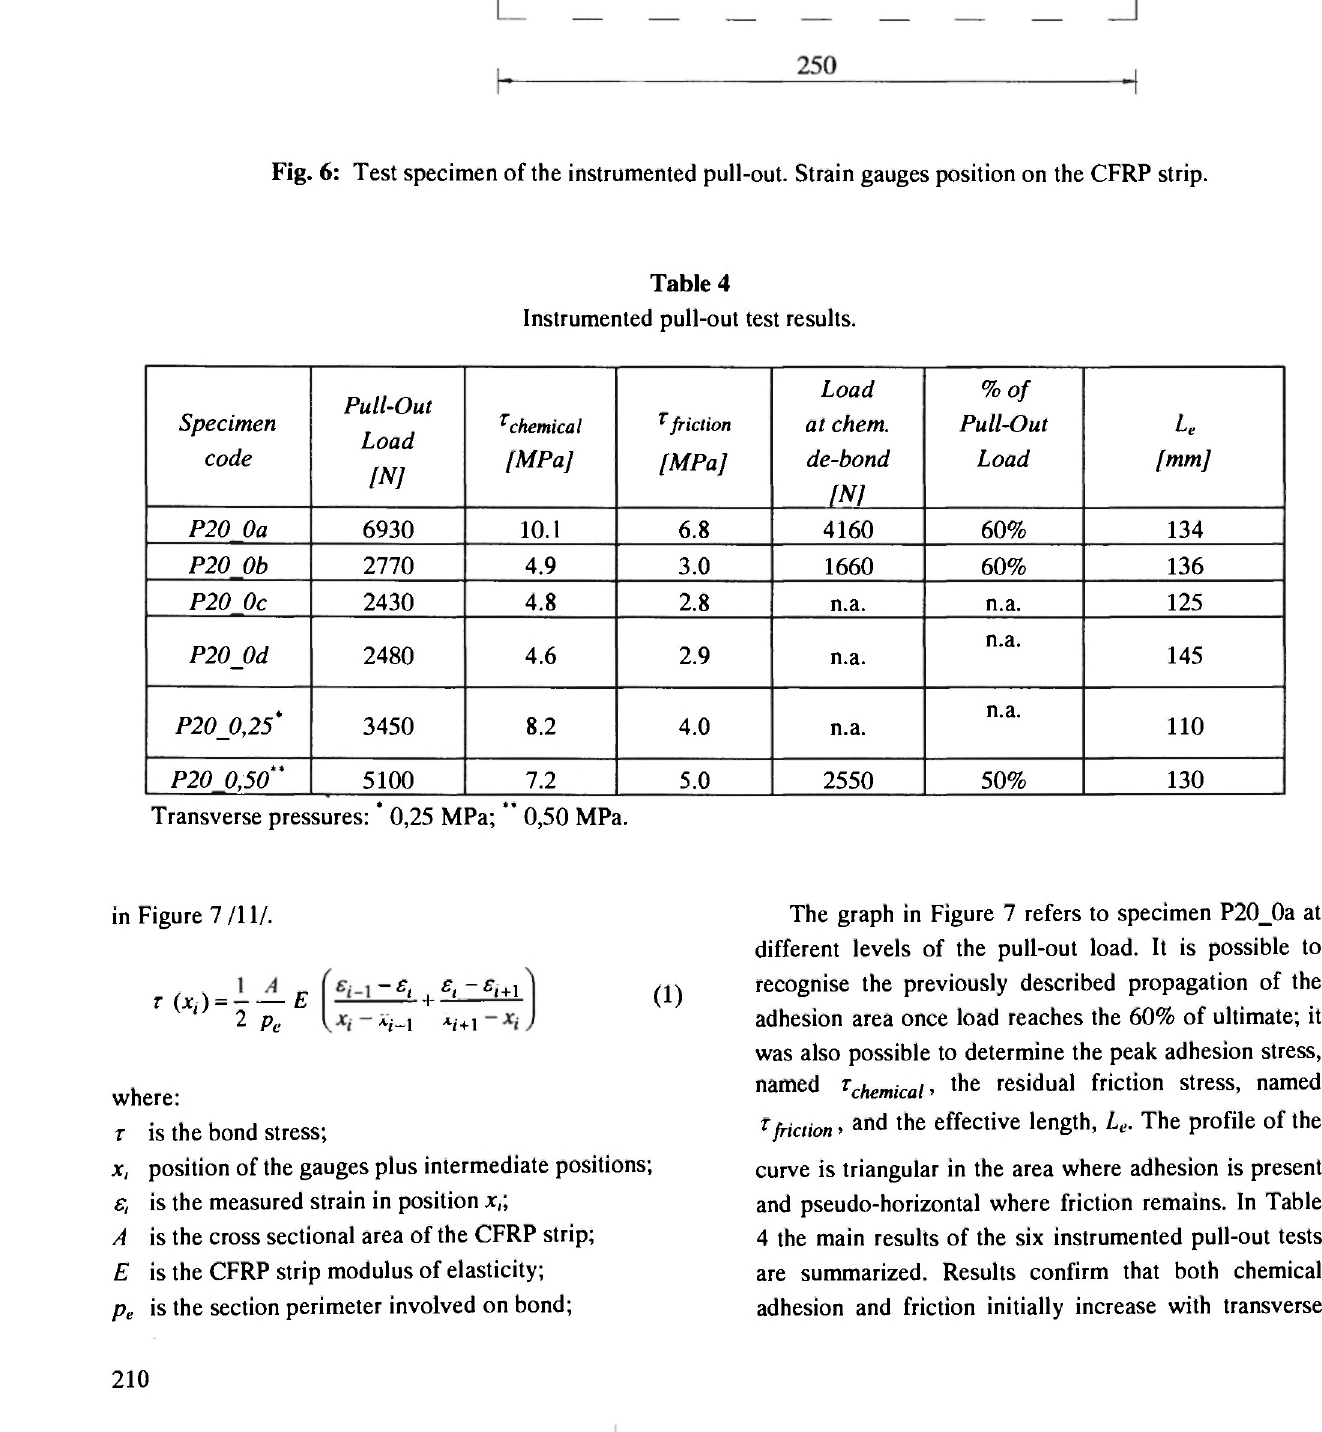
Instrumented pull-out test